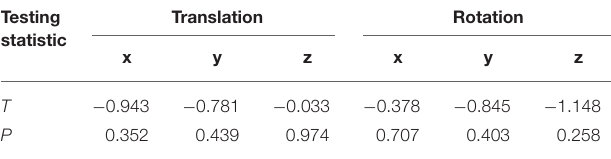
TABLE 2 | Difference in head motion of the patients and the